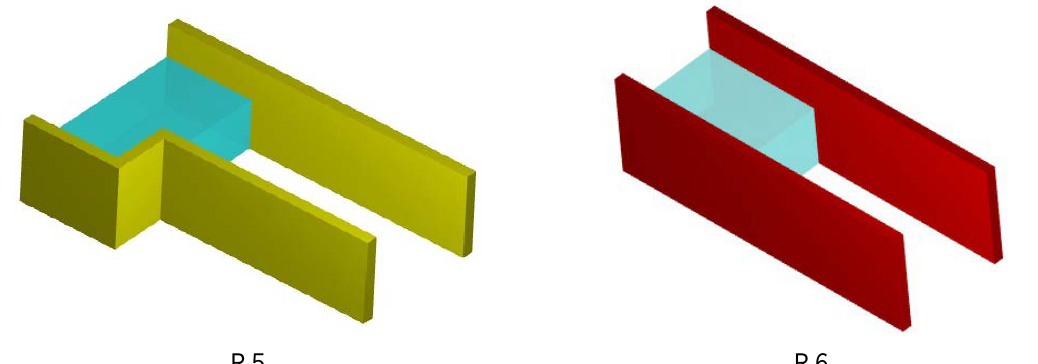
Fig. 3. Dam-break models for R1 (Mahabad Dam); R2 (Tignes Dam); R3 (30 degree); R4 (45 degree); R5 (Bend); and R6 (Long).